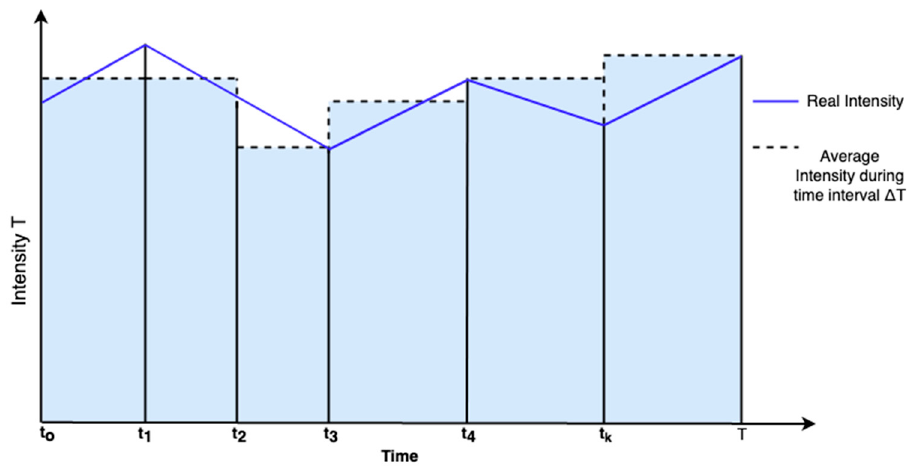
Figure 4. Hyetograph for actual and average rainfall intensity during time interval.